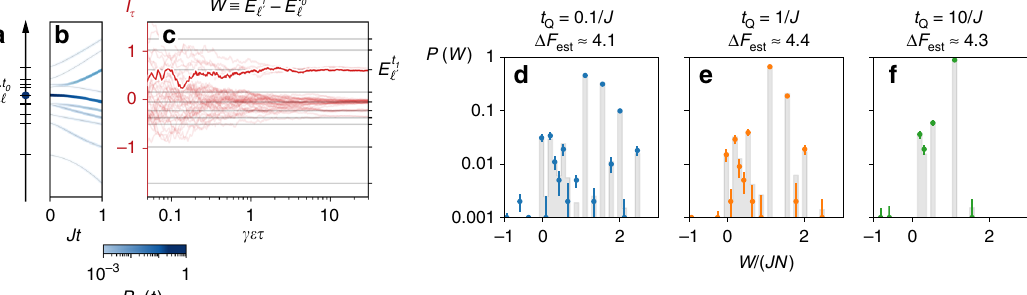
Fig. 4 Veri fi cation of Jarzynski equality (7) for the transverse- fi eld Ising model with fi ve spins. A single realization of the proposed protocol consists of , b the free evolution under a a the projection of the initial thermal state of spins to an eigenstate E t 0 ‘ of the initial Hamiltonian with transverse- fi eld value h t 0 linear change of the transverse fi eld h during time t Q = t 1 − t 0 (probabilities P ℓ ( t ) to populate the instantaneous energy eigenstates are shown in shades of blue), c The fi nal energy read-out E t 1 ‘ of the system at transverse- fi eld h t (photocurrent realizations for simulated experimental runs are shown in red), 1 resulting in the work W (see text) performed during the non-equilibrium process. d – f The resulting work probability distribution Pð W Þ for h t ¼ 2 J , 0 h : 5 J , α = 2, β = 0.5 ∕ J , and various quench times t W . The color dots with the t 1 ¼ 0 Q . The gray bars show theoretical probability as a function of work corresponding vertical error bars (one standard deviation) show the estimated probabilities for 1000 simulated experimental runs. Independent of the quench duration the Jarzynski relation (7) yields similar estimations of the free energy difference Δ F est ( fl uctuating due to the fi nite number of runs) with the true value given by Δ F ≈